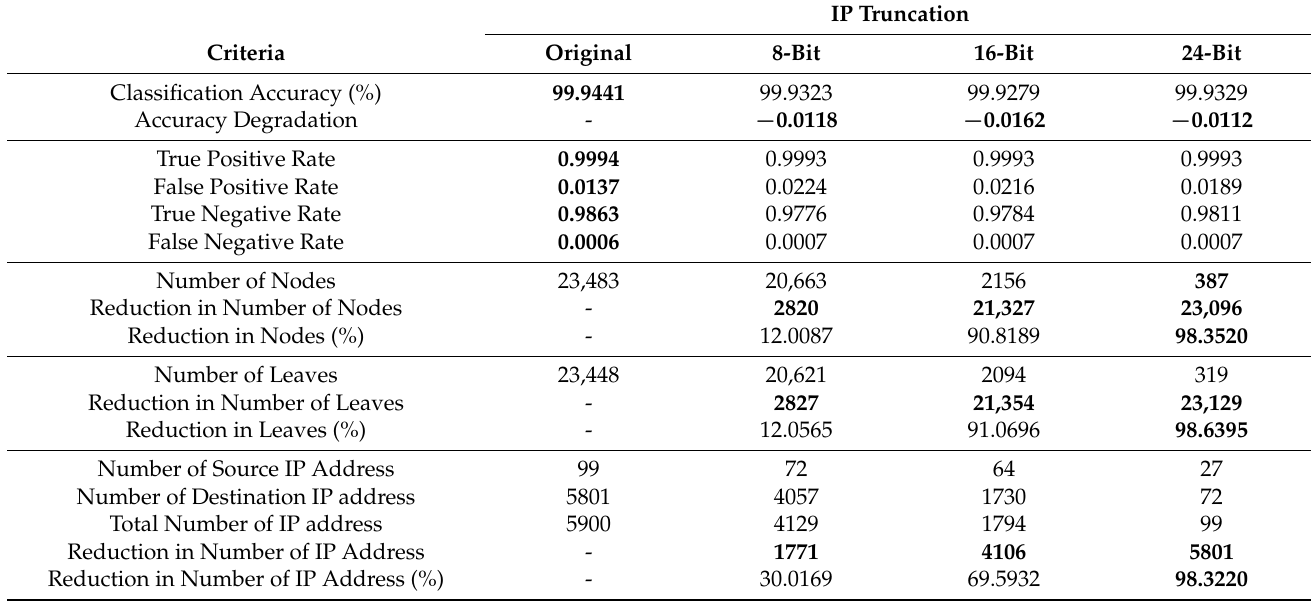
Table 1. Performance Comparison of Each Model in 6